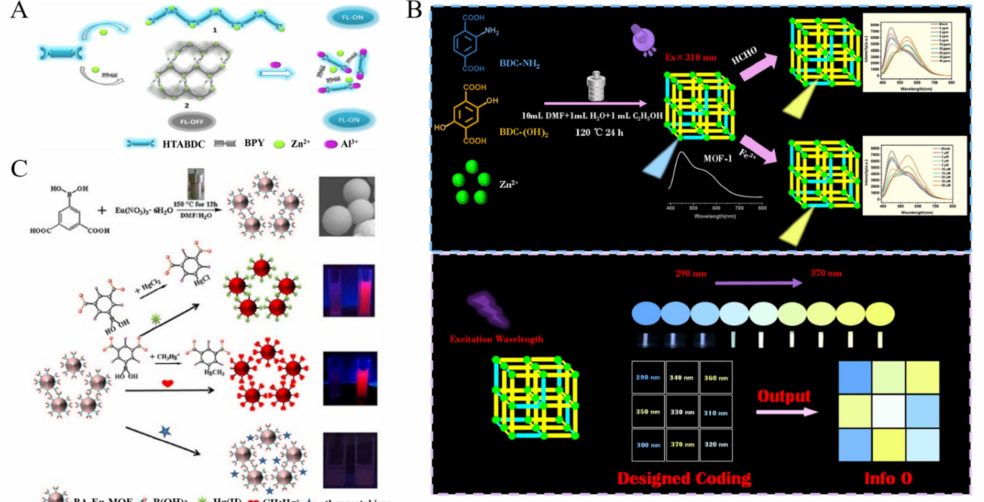
Figure 3. ( A ) Schematic illustration of the AIE-active MOFs-based sensor for the detection of Al 3+ . Reproduced with permission [69]. Copyright 2018, American Chemical Society. ( B ) Schematic illustration of BA-Eu-MOF synthesis and the sensing process of BA-Eu-MOF toward Hg 2+ and CH 3 Hg + ions based on transmetalation. Reproduced with permission [75]. Copyright 2016, American Chemical Society. ( C ) Schematic illustration of the design principle of dual-emission Eu-DATA/BDC MOFs and the ratiometric sensing and visible detection of Cu 2+ ions in human serum. Reproduced with permission [79]. Copyright 2022,